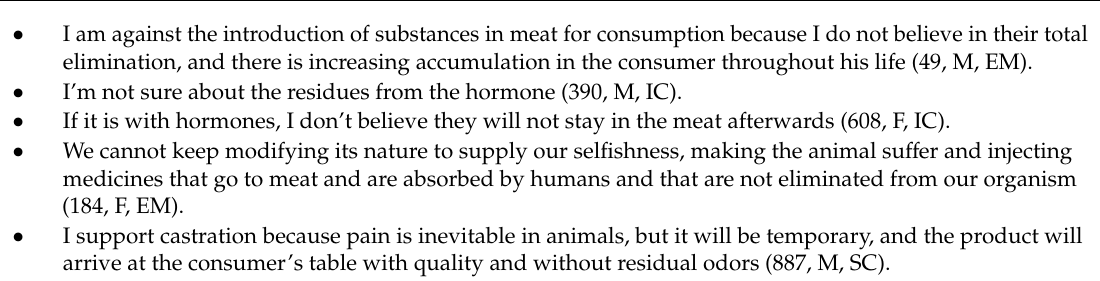
Table A2. Cont. Risks for Consumers (Residues in